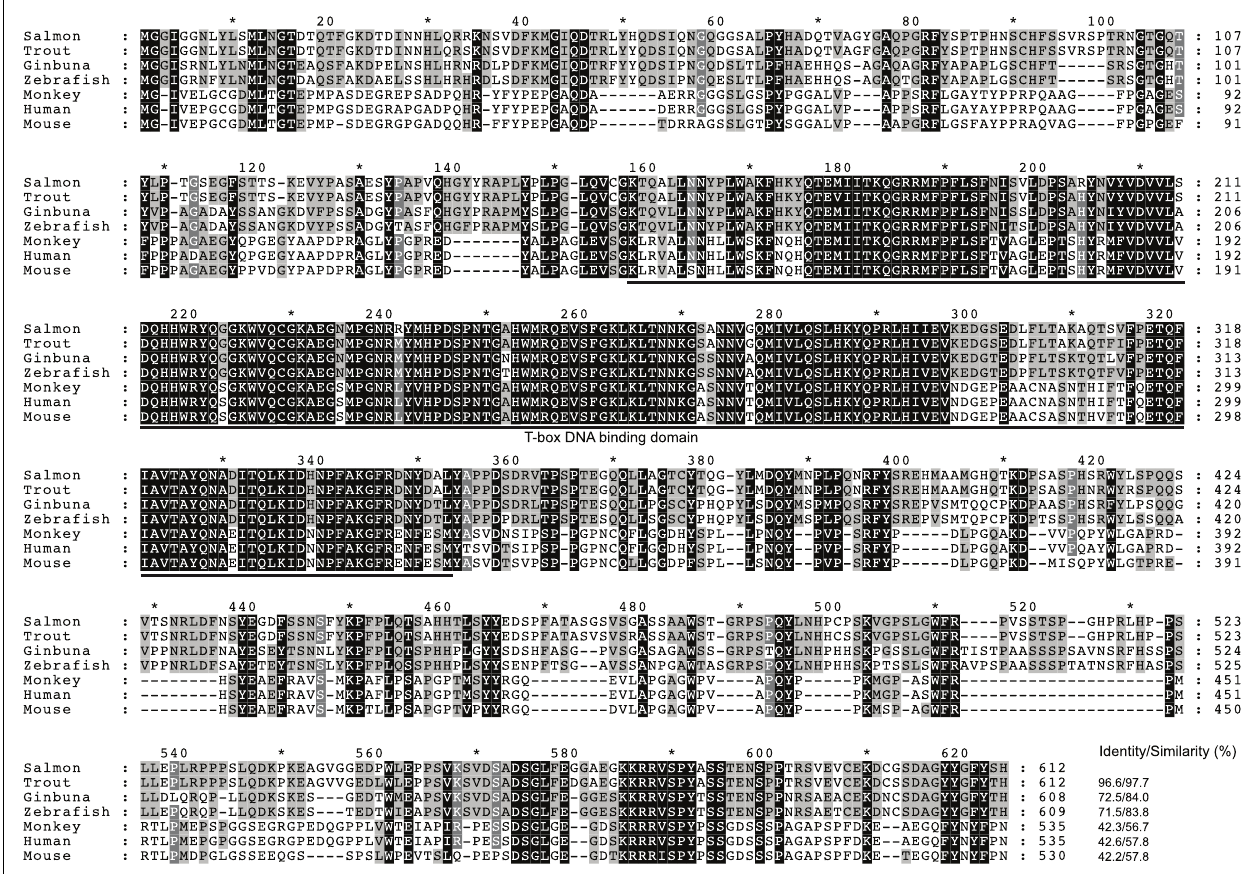
FIGURE 2 | Multiple sequence alignment of the deduced amino acid sequences from salmon T-bet and other vertebrates by the ClustalW2 program . Residues shaded in black are completely conserved across all